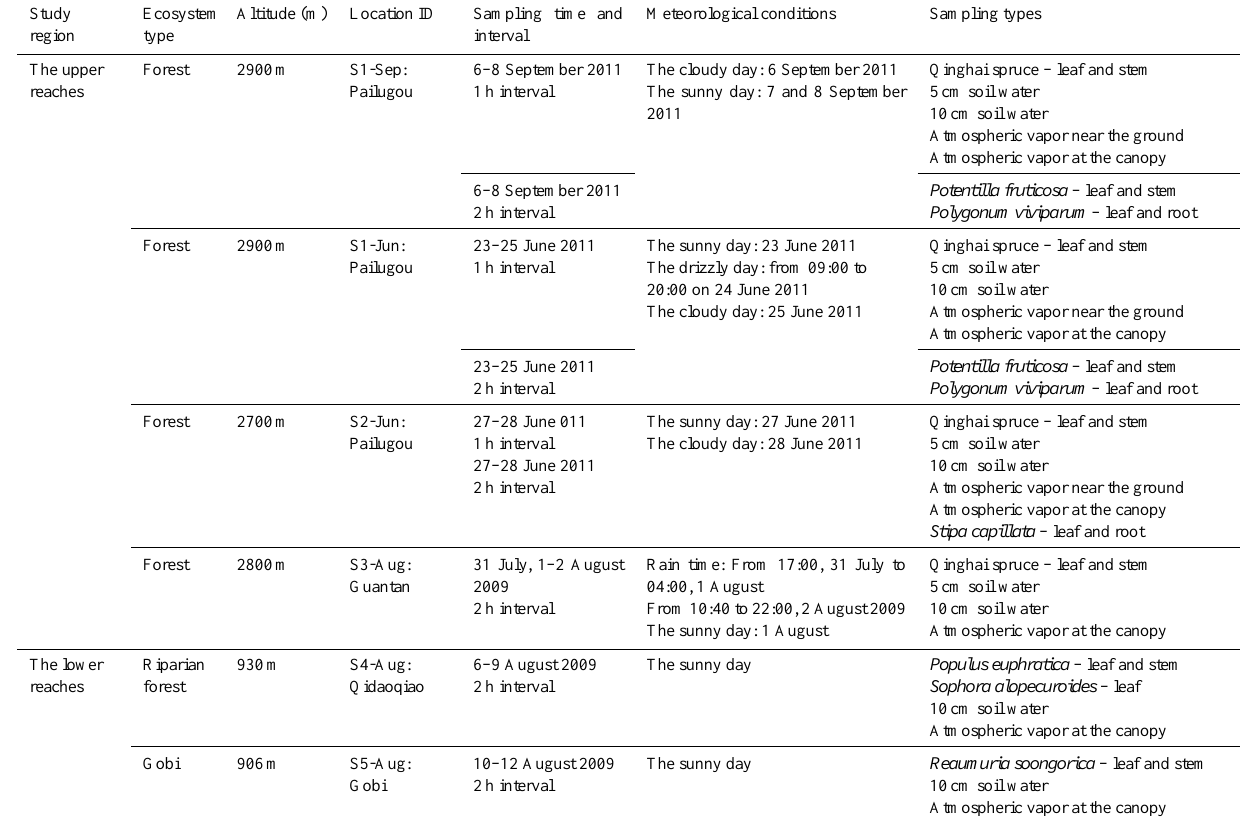
Table 1. The vegetation types, sampling dates and time, and sampling types at the sampling sites in the Heihe River basin. Study region